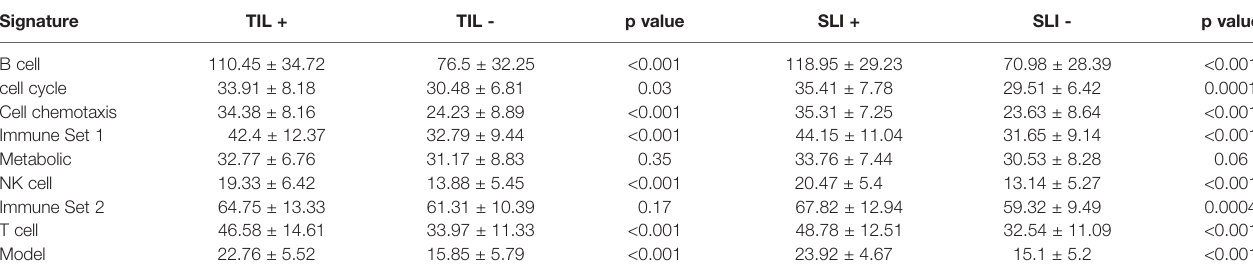
TABLE 3 | The signatures in GSE58984 between different intratumoral lymphocytic in fi ltration (TIL) and stromal lymphocytic in fi ltration (SLI)